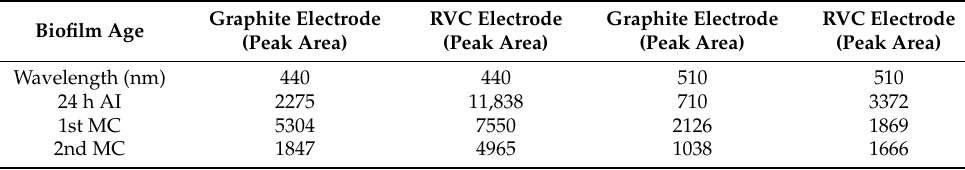
Table 1. Peak area of cytochromes and riboflavin at different biofilm